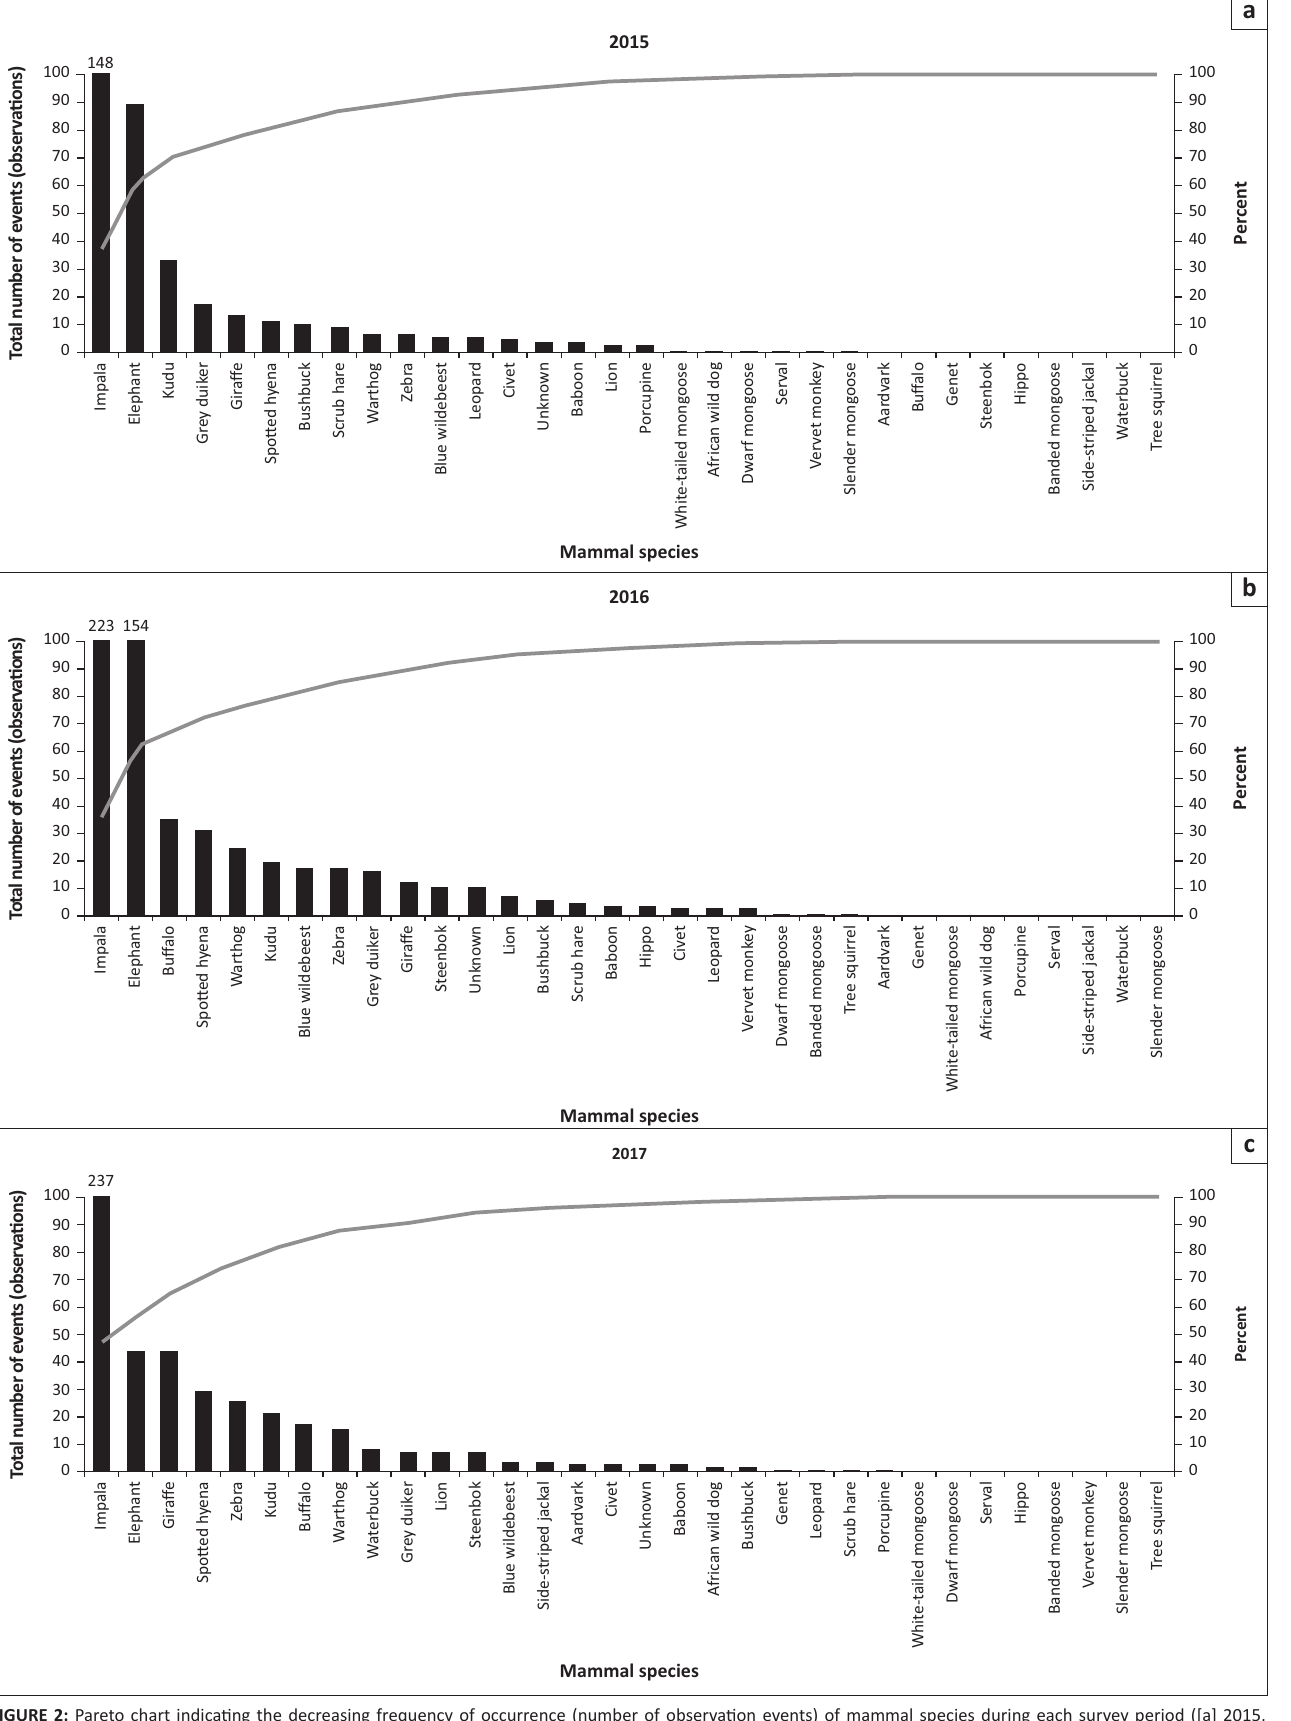
FIGURE 2: Pareto chart indicating the decreasing frequency of occurrence (number of observation events) of mammal species during each survey period ([a] 2015, [b] 2016 and [c] 2017) on the left axis (bars) and the cumulative percentage of the total number of occurrences on the right axis